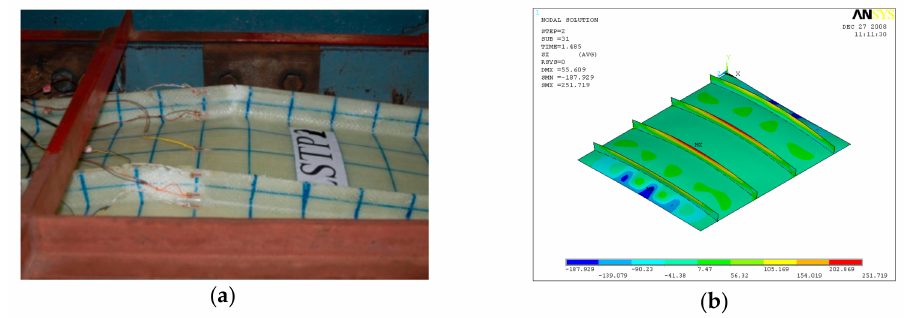
Figure 17. Failure of LSTP2. ( a ) Experiment ( b ) FEA.